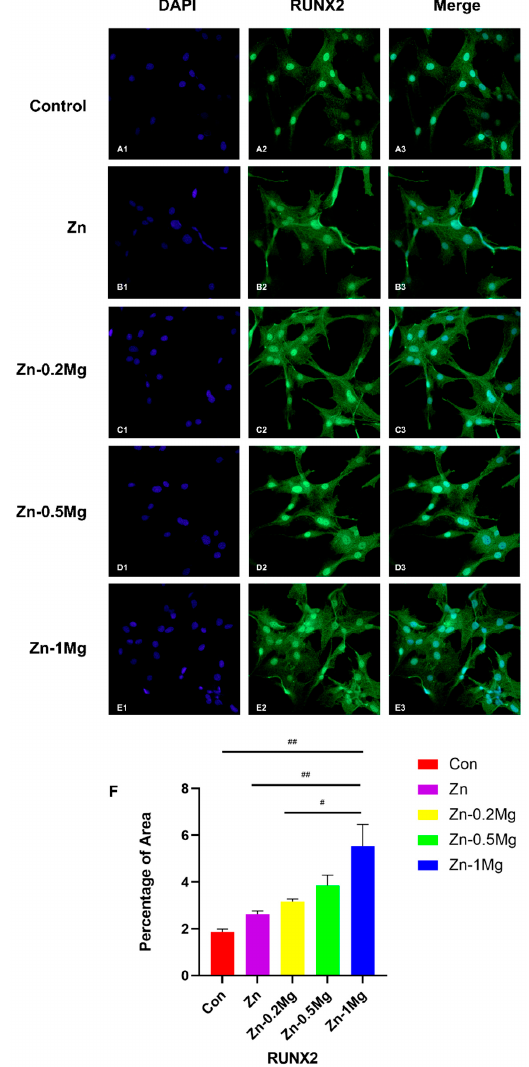
Figure 6. Representative immunofluorescence staining images of ( A1 – A3 were the control group, B1 – B3 were the Zn group, C1 – C3 were the Zn-0.2Mg group, D1 – D3 were the Zn-0.5Mg group, E1 – E3 were the Zn-1Mg group) MC3T3-E1 and ( F ) the quantitative results. ## p < 0.01 and # p < 0.05, compared with Zn–1Mg group.